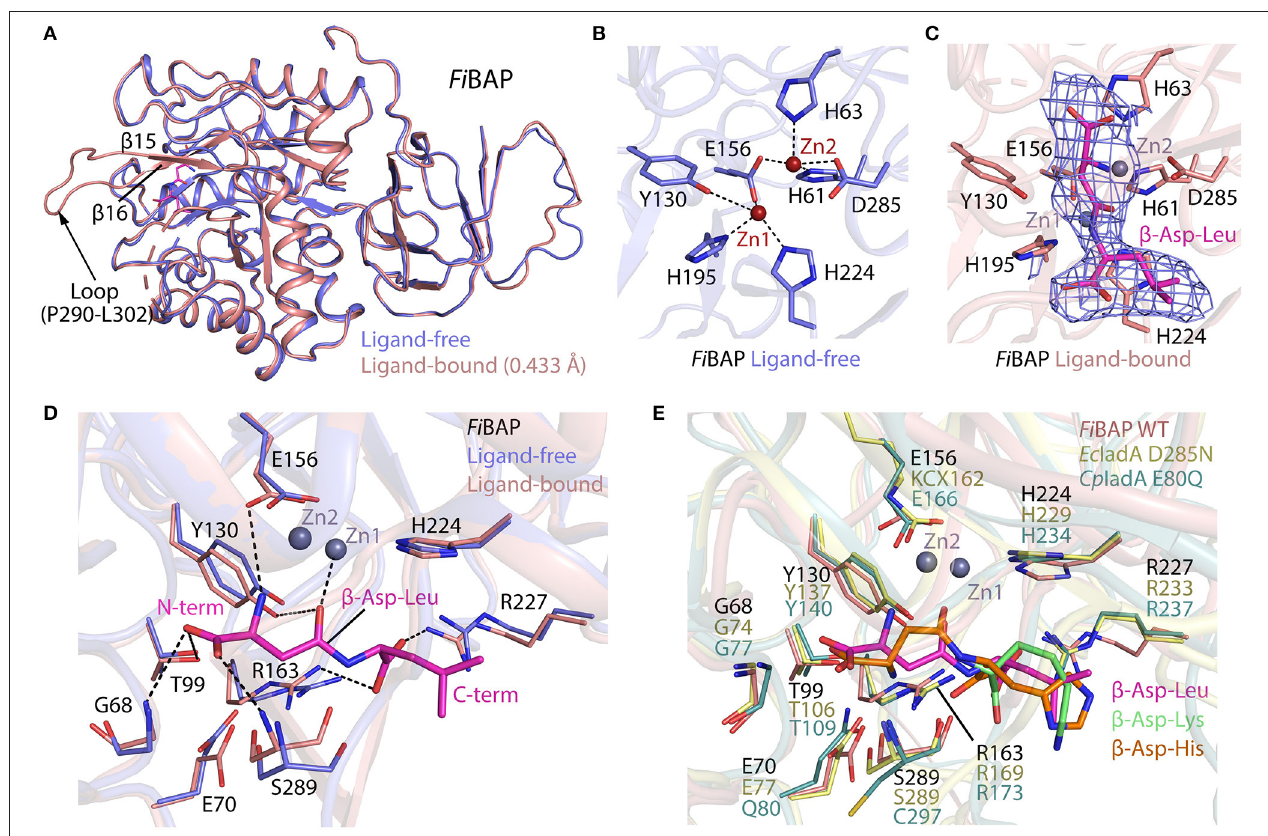
FIGURE 5 | Comparison of ligand-bound and ligand-free structures of Fi BAP. (A) Alignment of ligand-bound and ligand-free Fi BAP monomers. Note that the P290–L302 loop is stabilized in the ligand-bound structure but not in the ligand-free model. (B) The active site of ligand-free Fi BAP containing binuclear zinc metal ions. Residues coordinating the metals are represented as sticks and H-bonds are shown as dotted lines. (C) The active site of ligand-bound Fi BAP. The 2Fo-Fc electron density maps of Zn 2 + ions and β -DL are contoured at 1 σ and colored blue. Residues of Fi BAP interacting with metal ions and β -DL are depicted as sticks. Zn 2 + ions are represented as purple spheres and the bound β -DL is shown as magenta sticks. Ligands and side chains are colored by atom type (oxygen in red, nitrogen in blue, phosphorous in orange). (D) Comparison of residues coordinating the ligand between ligand-free and ligand bound models. Interactions between ligand-bound Fi BAP residues and atoms of the ligand are shown as dotted lines. (E) Comparison of the ligand-binding residues of Fi BAP bound to β -DL with their counterparts in ligand-bound homologs Ec IadA (PDB_1YBQ) and Cp IadA (PDB_5XGX). Conformational changes in side-chains are indicated. Residues coordinating the ligand are highly conserved among